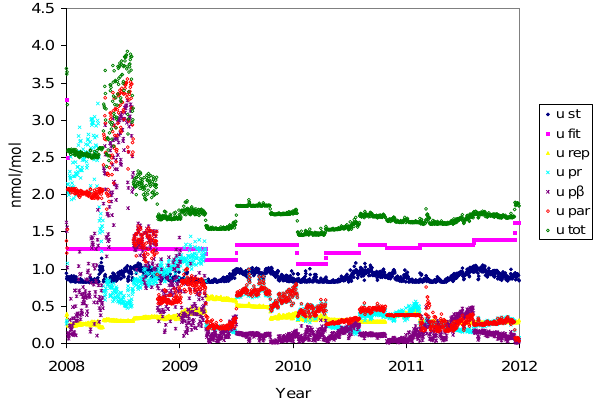
Fig. 5. Uncertainty components (daily means) of the measured CO mole